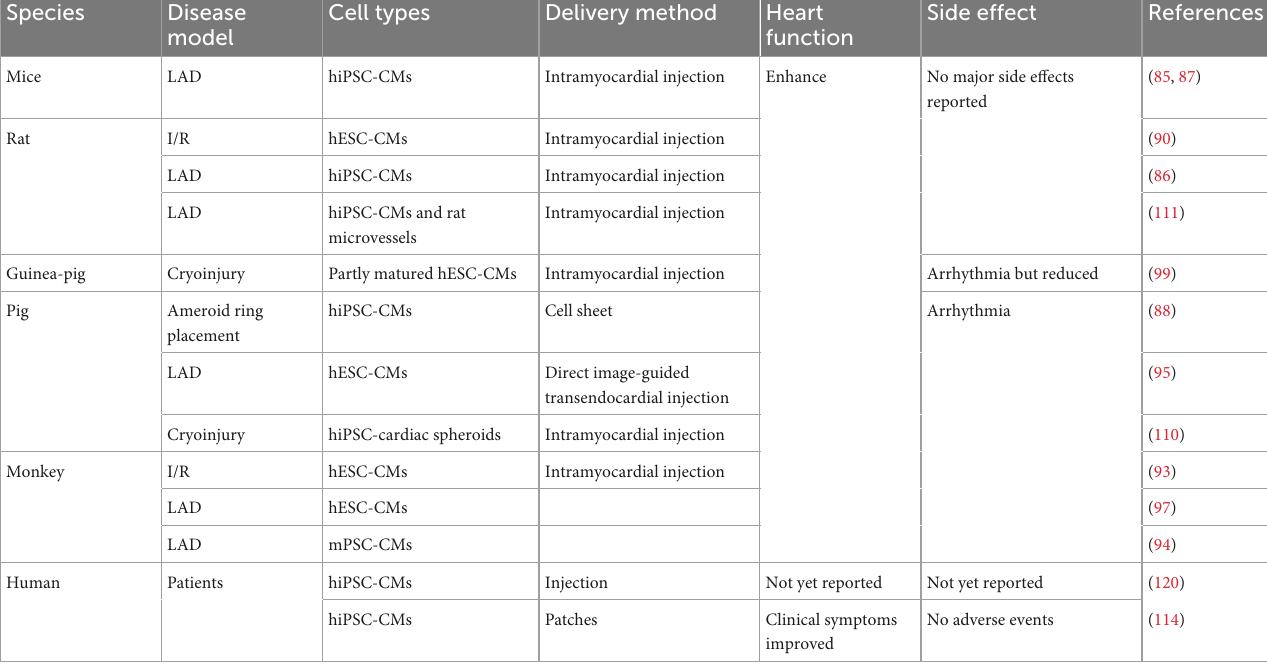
TABLE 2 Preclinical and clinical studies of hPSC-CMs transplantations for treatment of cardiac disease.